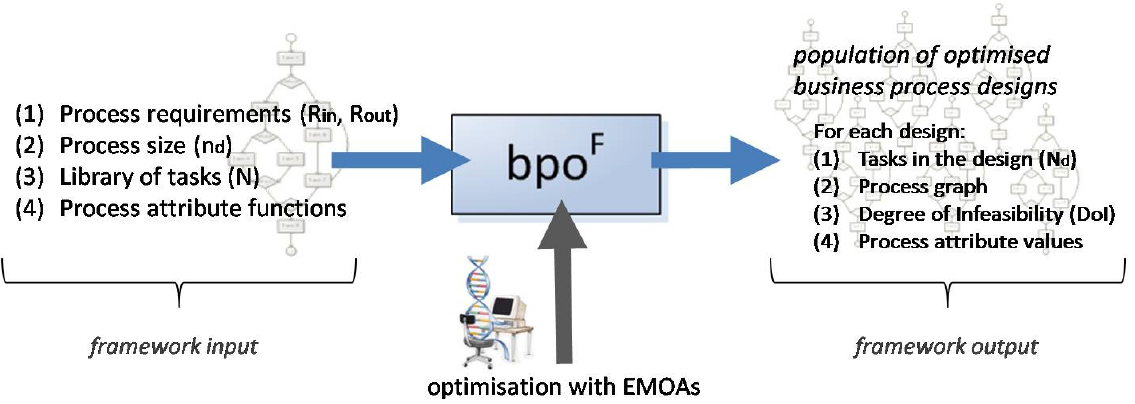
Figure 1. The inputs and outputs of the bpo F [5].